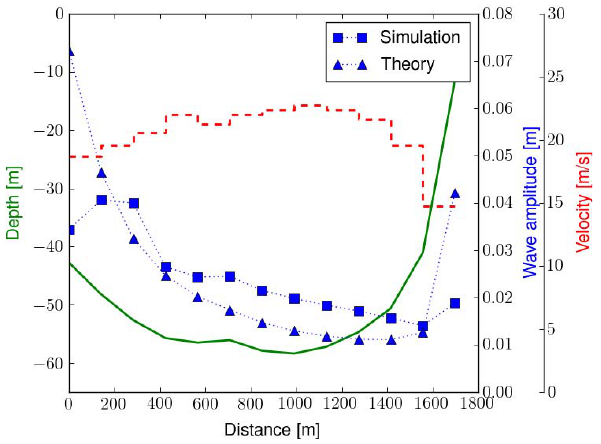
Fig. 6e. Wave propagation in east direction.